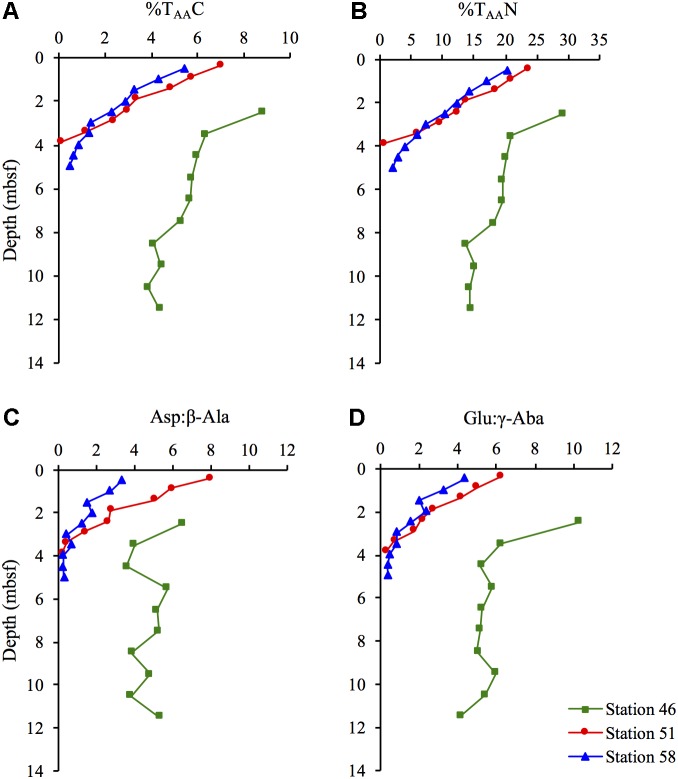
(A) percentage of total organic carbon present as amino acid carbon (%TAAC) and (B) percentage of total nitrogen present as amino acid nitrogen (%TAAN) and the ratio between the two amino acid precursors and their degradation products (C) Asp:β-Ala, and (D) Glu:γ-Aba at Station 46, 51, and 58.